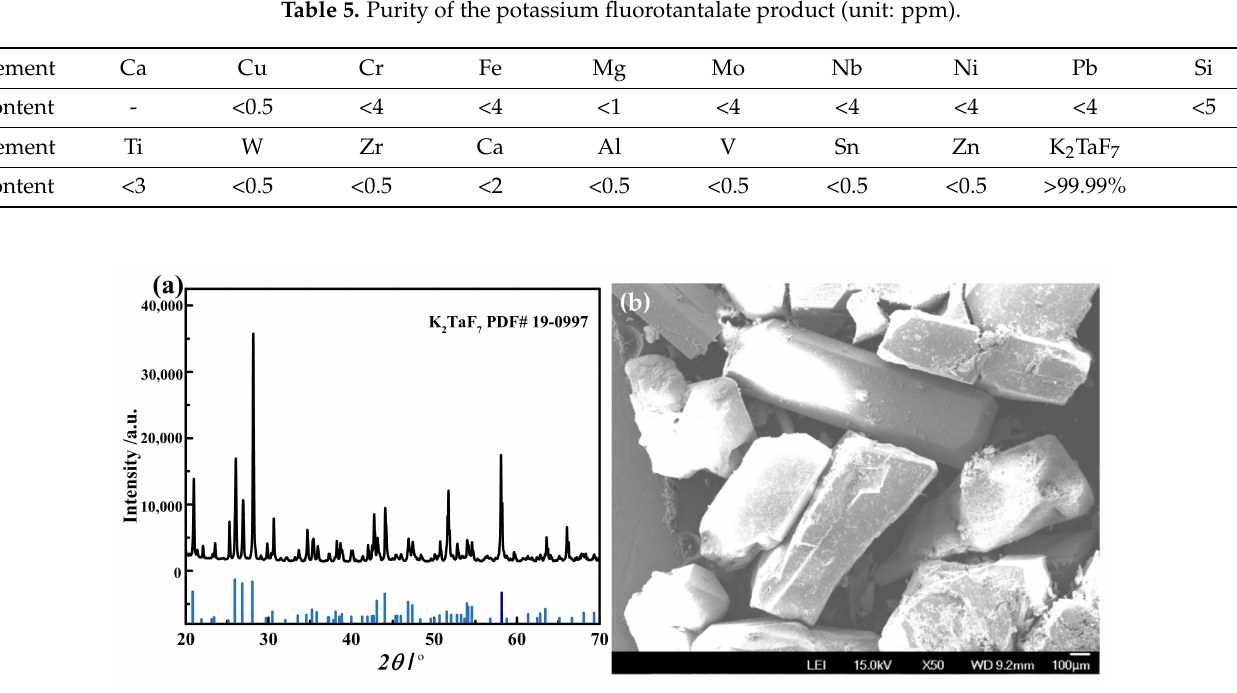
Figure 12. The XRD pattern ( a ) and SEM image ( b ) of thepotassiumfluorotantalate